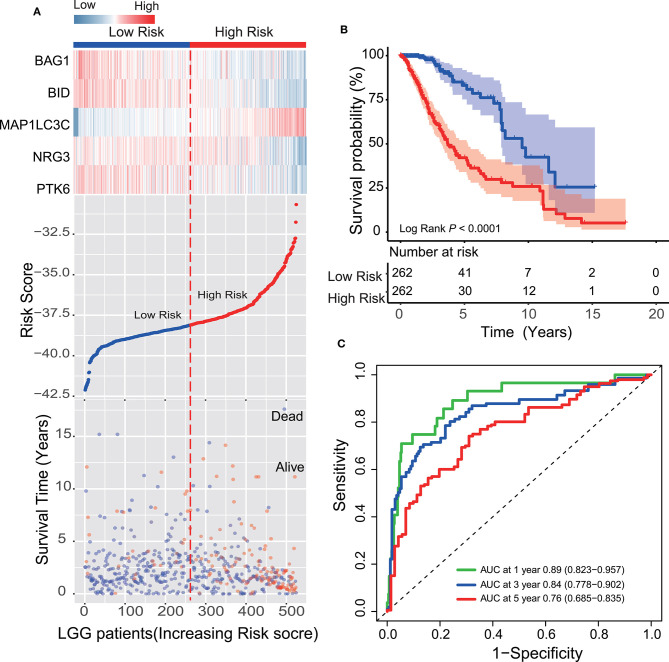
Survival prediction performance of the ATG signature in the training dataset. (A) Expression heatmap of the five ATGs, dot plot of risk scores and survival status of LGG patients in the training dataset. (B) Kaplan–Meier analysis demonstrated that the five-ATG signature divided patients into two risk groups with different survival. (C) Time-dependent ROC analysis of the ATG signature in the training group.